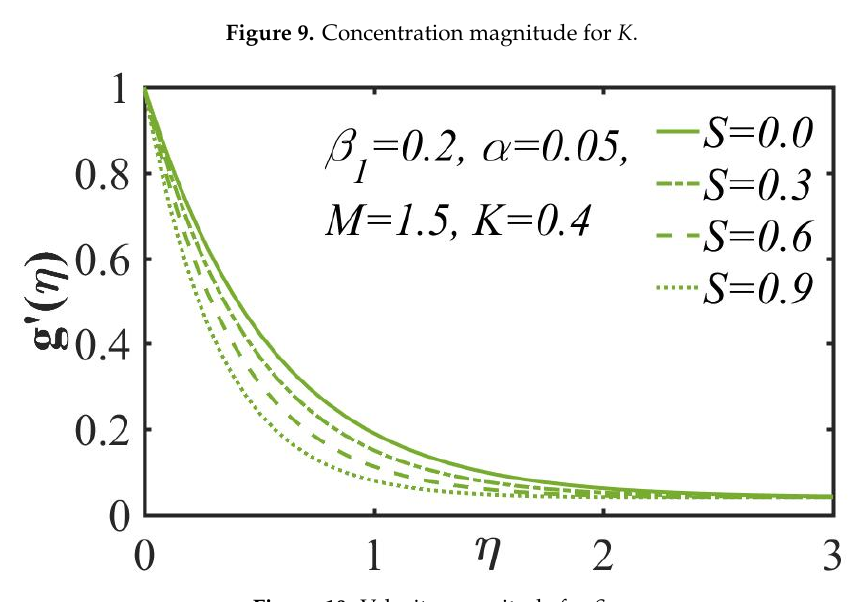
Figure 10. Velocity magnitude for (cid:1845) .